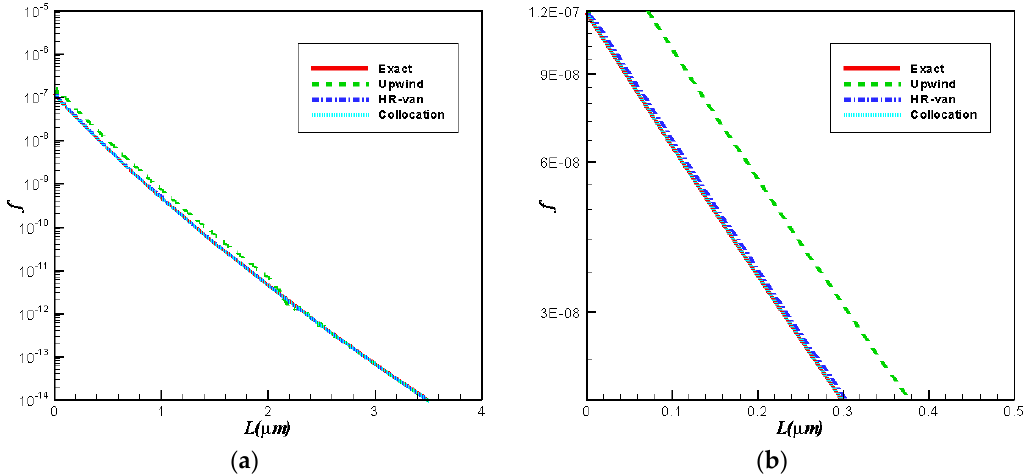
Figure 6. Comparison for final CSD with analytical and numerical results: ( a ) in the whole crystal; ( b ) zoomed figure. Table 4. L 1 and L 2 errors for different numerical schemes.